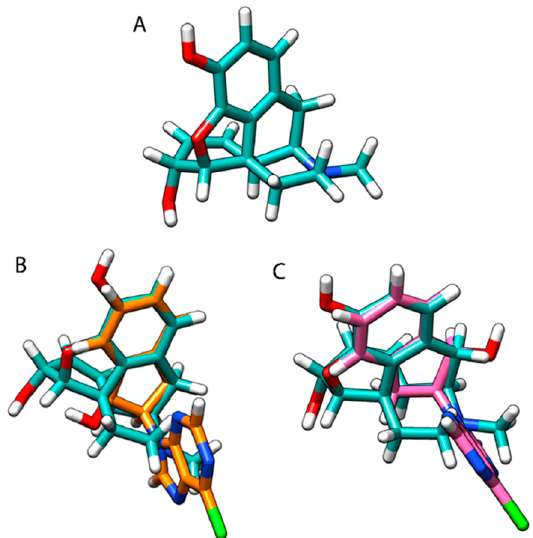
Figure 9. Molecular modeling of compound 5 and morphine: ( A ) Morphine optimized structure. ( B ) 1 R ,2 S enantiomer of compound 5 superimposed on the pharmacophore of morphine (RMSD: 0.275). ( C ) 1 S ,2 R enantiomer of compound 5 superimposed on the pharmacophore of morphine (RMSD: 0.274) .